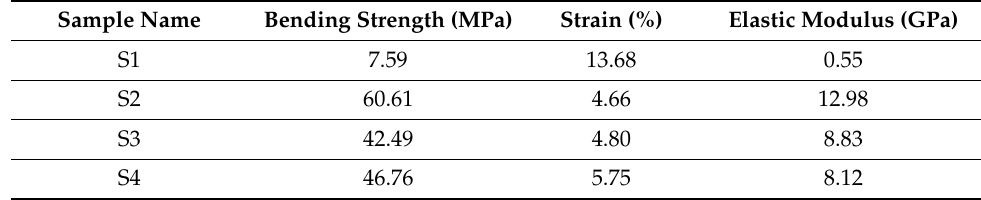
Table 6. Bending properties of JCJC spent tea leaf composites.